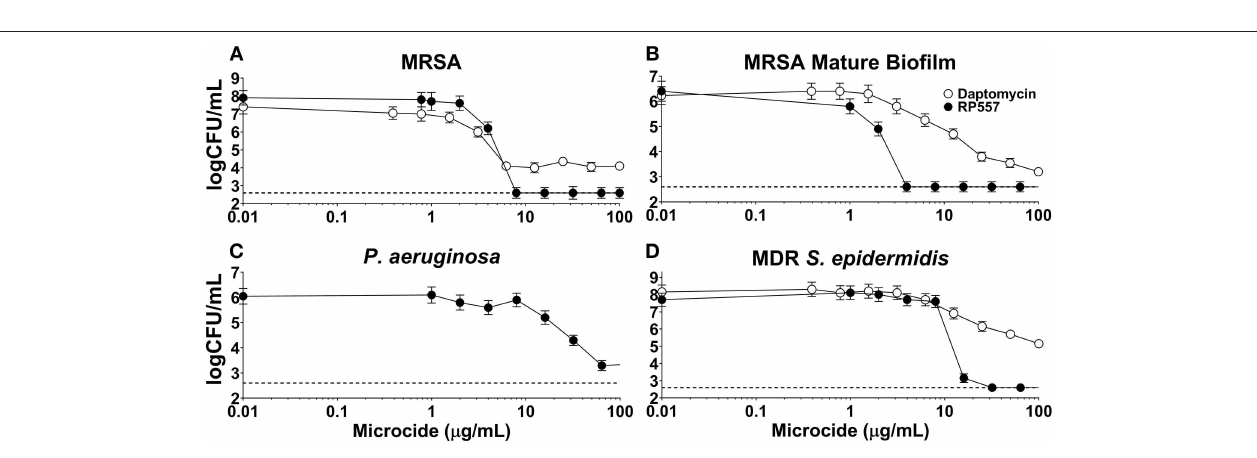
FIGURE 7 | RP557 disrupts P. aeruginosa , multidrug resistant S. epidermidis and MRSA biofilms, including mature biofilm. Dose-dependent concentration response of RP557 against 6 hr MRSA ATCC 1556 (A) , mature (120h) MRSA ATCC 1556 (B) , P. aeruginosa P14 (C) , and MDR S. epidermidis ATCC 700578 (D)